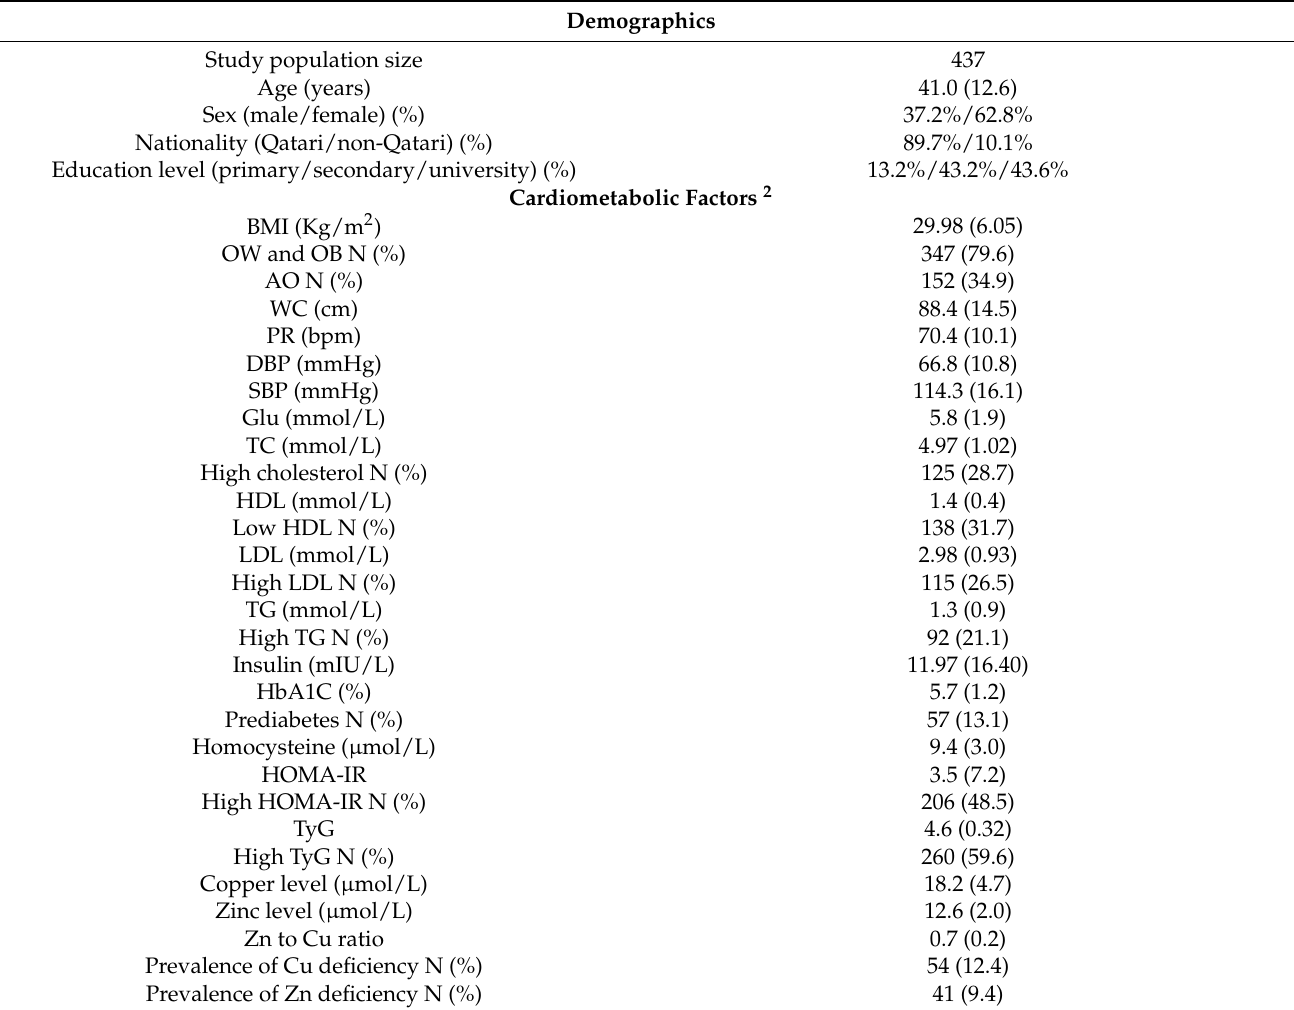
Table 1. Baseline characteristics of the study population 1